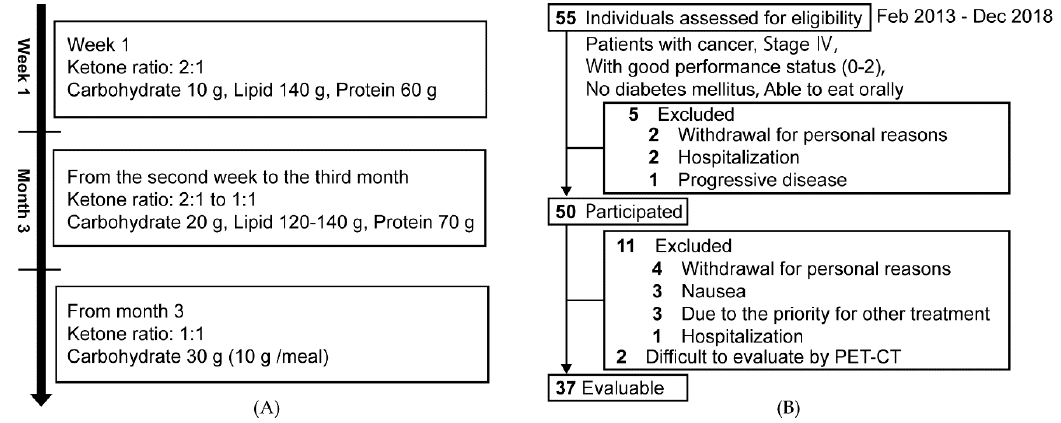
Figure 1. Ketogenic diet for patients with cancer. ( A ) Regimen of the ketogenic diet for cancer patients. The ketone ratio is calculated as: lipid/protein + carbohydrate. Daily caloric intake is 30 kcal/kg ideal body weight. Medium chain triglyceride (MCT) oil and a ketogenic formula are used for calorie supplementation. ( B ) Flow diagram of 37 evaluable patients from among the 55 participants.